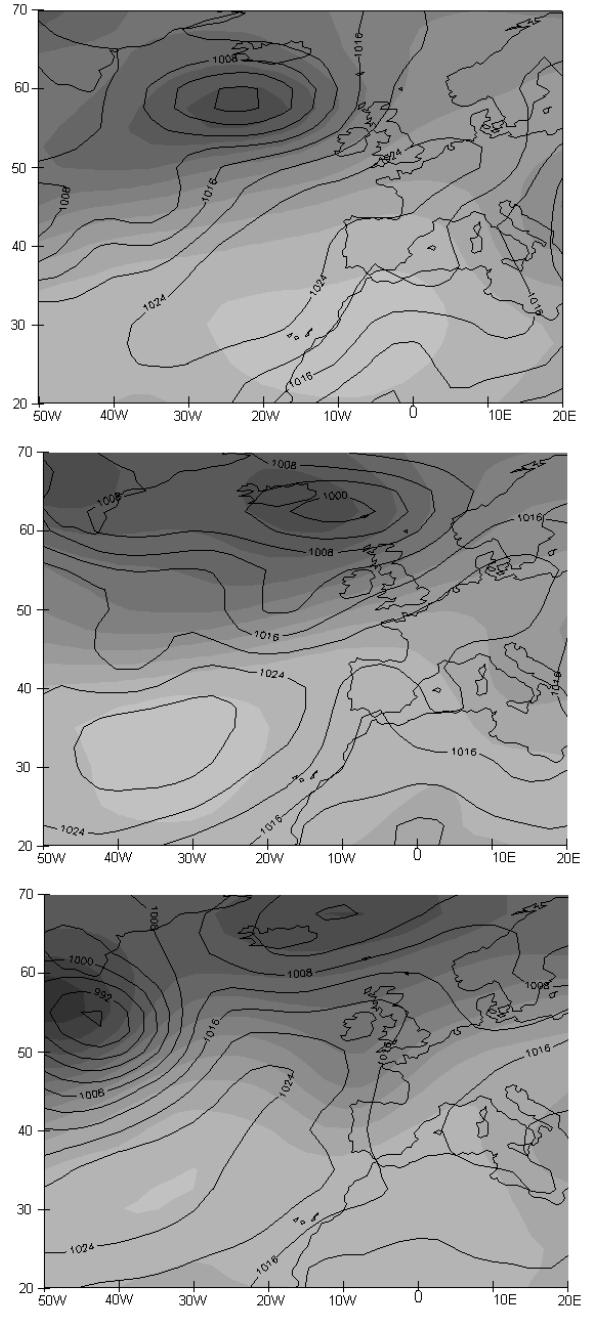
Fig. 7. SLP and Z 500 field for 3, 5 and 7